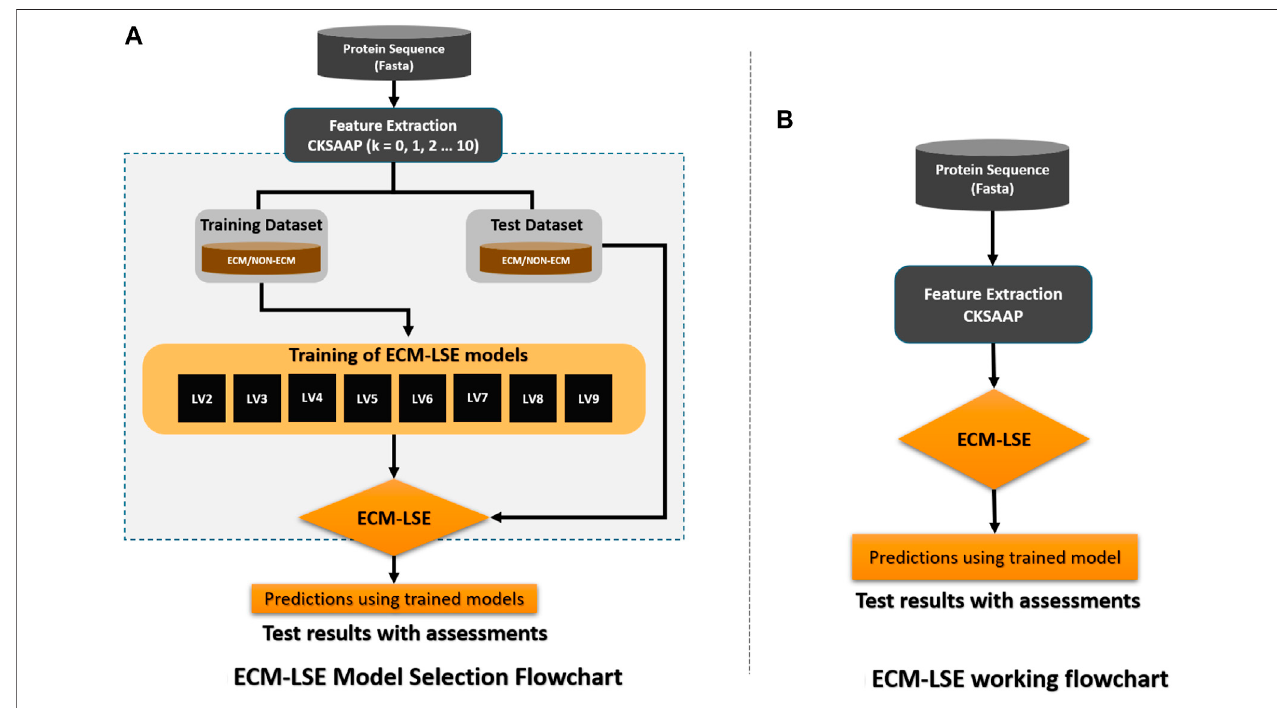
FIGURE 3 | Work fl ow of the proposed ECM-LSE method.